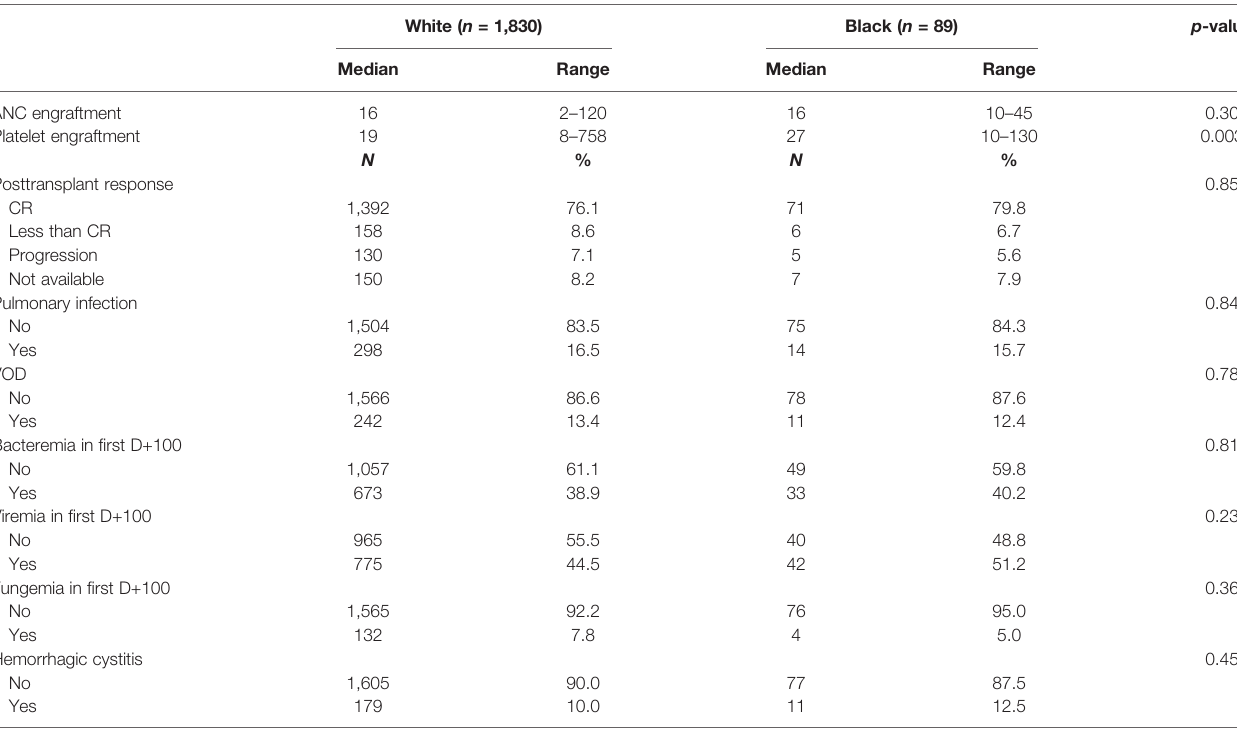
TABLE 3 | Transplant outcomes by